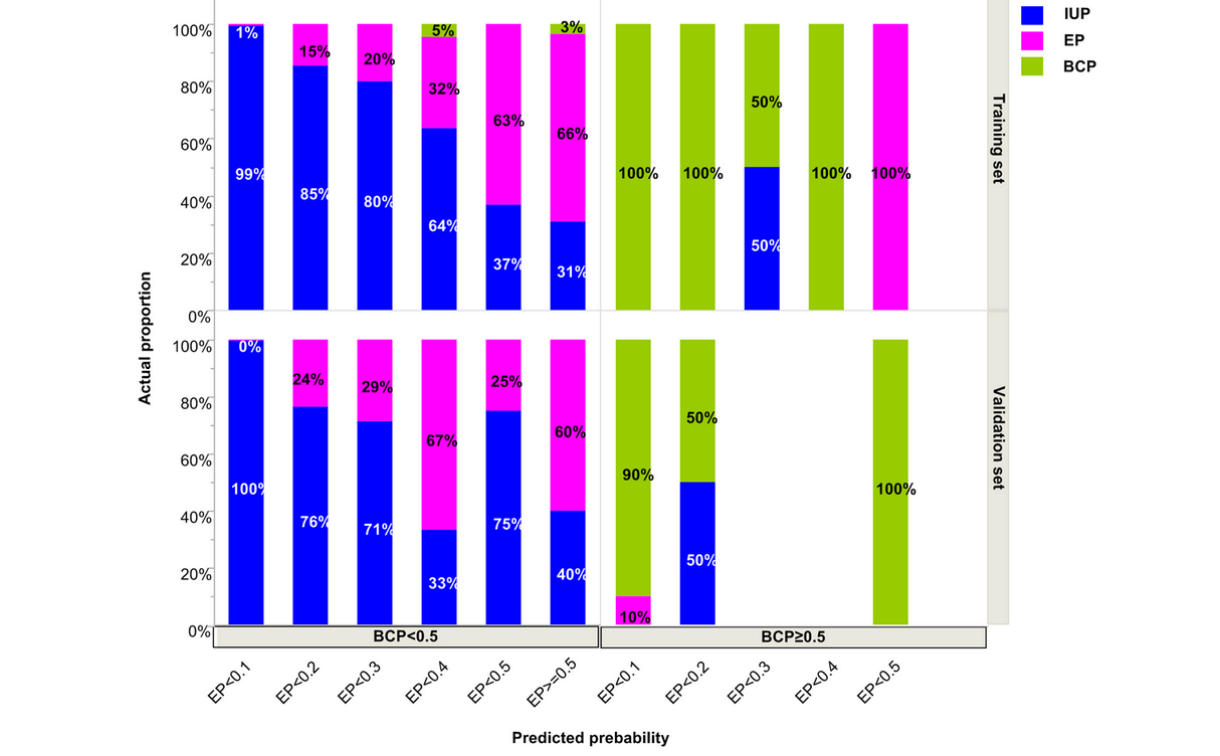
Figure 3. Classifying the population into subgroups according to the predicted probabilities of IUP, EP, and BCP using a training set and a validation